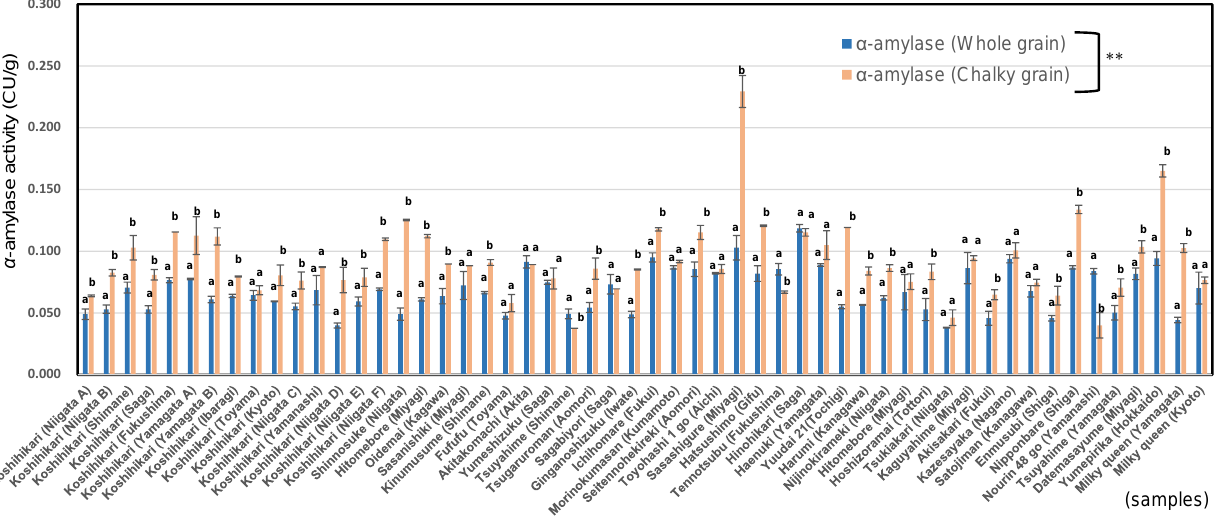
Figure 3. α - amylase activities of whole and chalky unpolished rice grains in 54 Japonica rice in 2020. Different letters (a, b) mean that whole and chalky grains in each same rice samples are significantly different. ** Correlation is significant at 1% by t -test by the method of Tukey’s multiple comparison. The ratios of α -amylase activities of chalky unpolished rice grains to whole unpolished rice grains in low-amylose rice (1.61 ± 0.1) was higher than those of premium rice Koshihikari (1.41 ± 0.2) and ordinary Japonica rice cultivars (1.32 ± 0.3). Chalky unpolished rice grains showed markedly higher α -amylase activities (1.3 – 1.7 times) than whole unpolished rice grains in 54 Japonica rice in 2020 (data not shown).